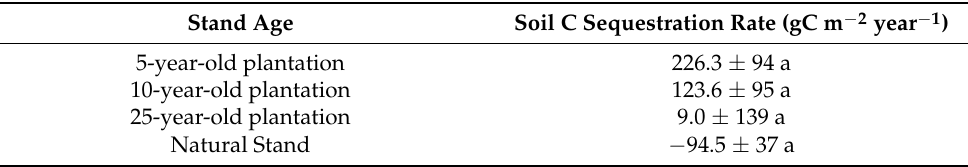
Natural Stand − 94.5 ± 37 a